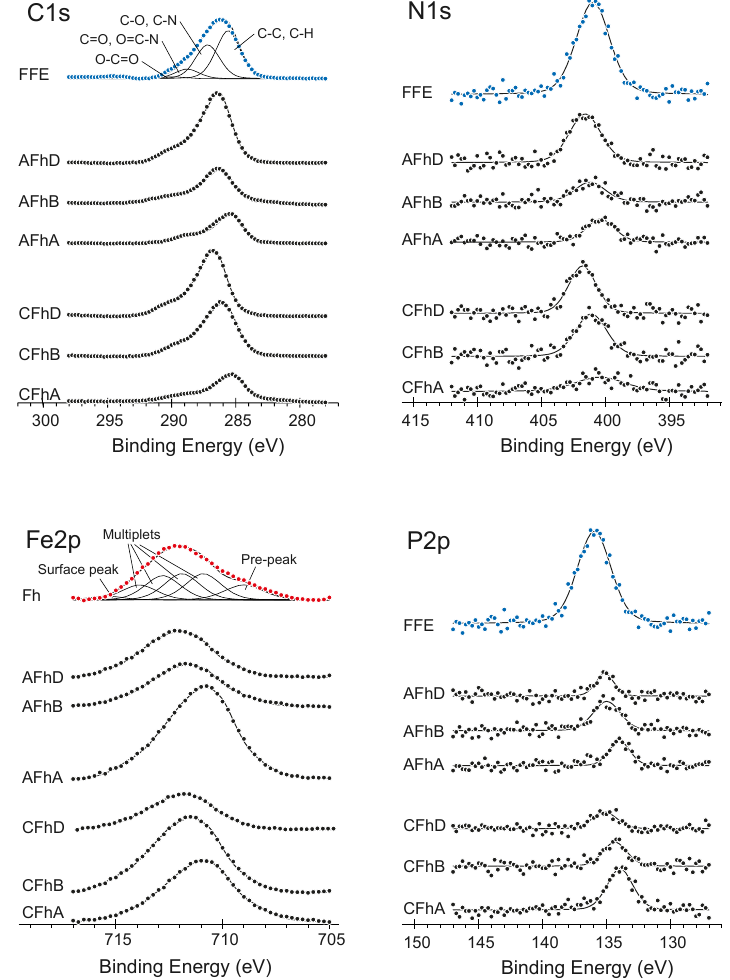
Figure 4. Background corrected XPS spectra of the control ferrihydrite (Fe2p, red), the forest-floor extract (C1s, N1s, P2p, blue), and the incubated coprecipitates and adsorption complexes. Refer to text for